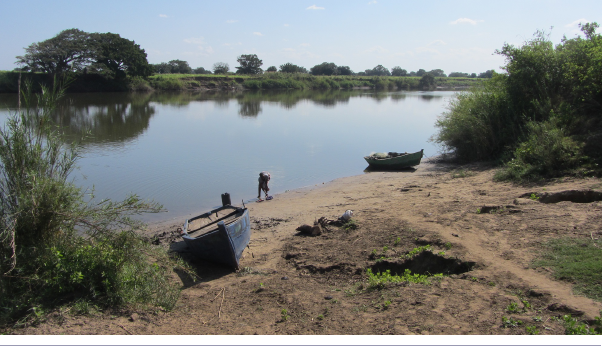
Fig. 4. Boats on the shore of the Limpopo